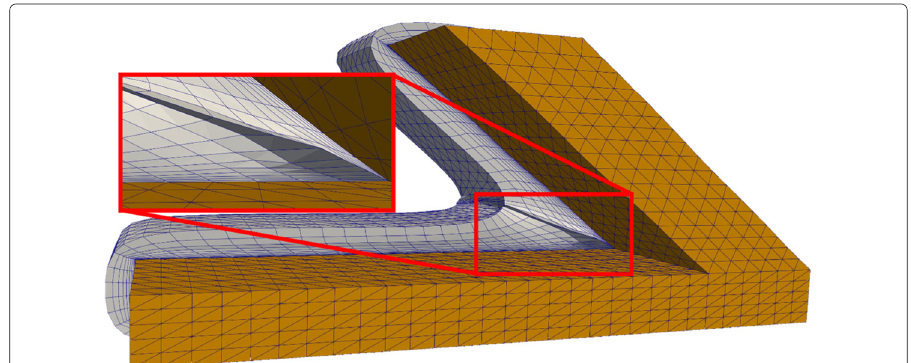
Fig. 8 Prismatic mesh of a model with the concave corner less than 90 degrees. It is a full prismatic mesh without collisions